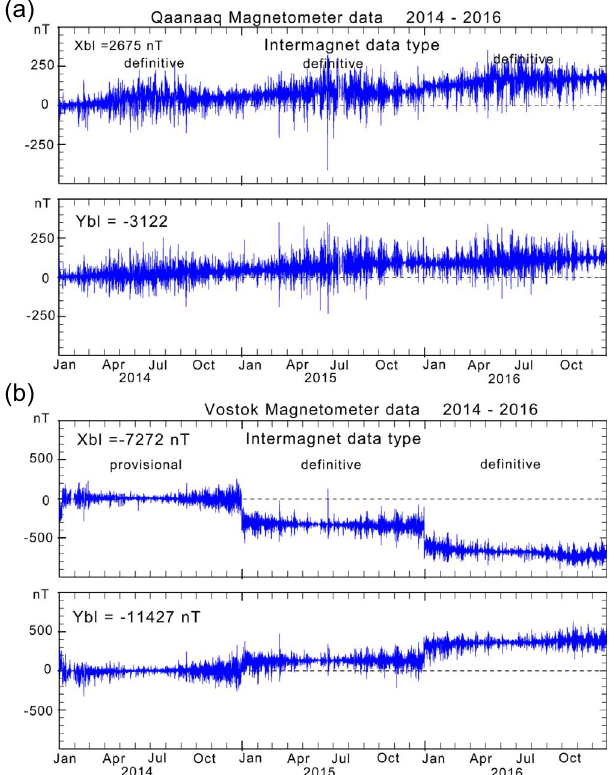
Fig. 2. (a) Average daily and (b) average seasonal variations in reverse convection intensities for Qaanaaq (THL) (blue line) and Vostok (red) de fi ned by the hourly product of amplitude (in nT) and duration (hours).